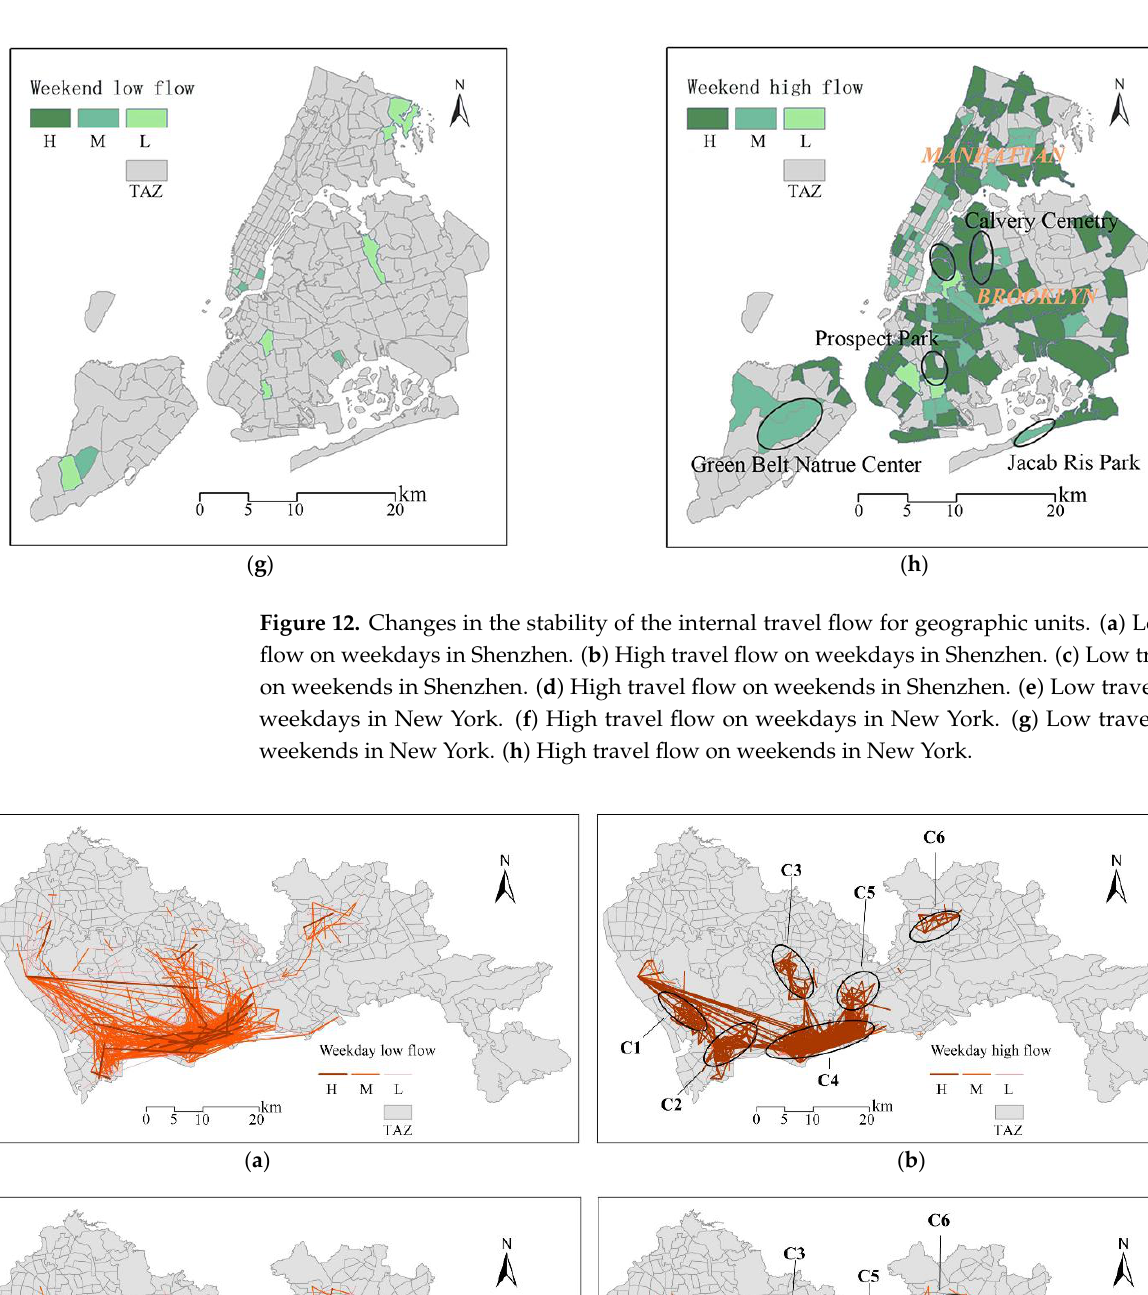
Figure 12. Changes in the stability of the internal travel flow for geographic units. ( a ) Low travel flow on weekdays in Shenzhen. ( b ) High travel flow on weekdays in Shenzhen. ( c ) Low travel flow on weekends in Shenzhen. ( d ) High travel flow on weekends in Shenzhen. ( e ) Low travel flow on weekdays in New York. ( f ) High travel flow on weekdays in New York. ( g ) Low travel flow on weekends in New York. ( h ) High travel flow on weekends in New York.